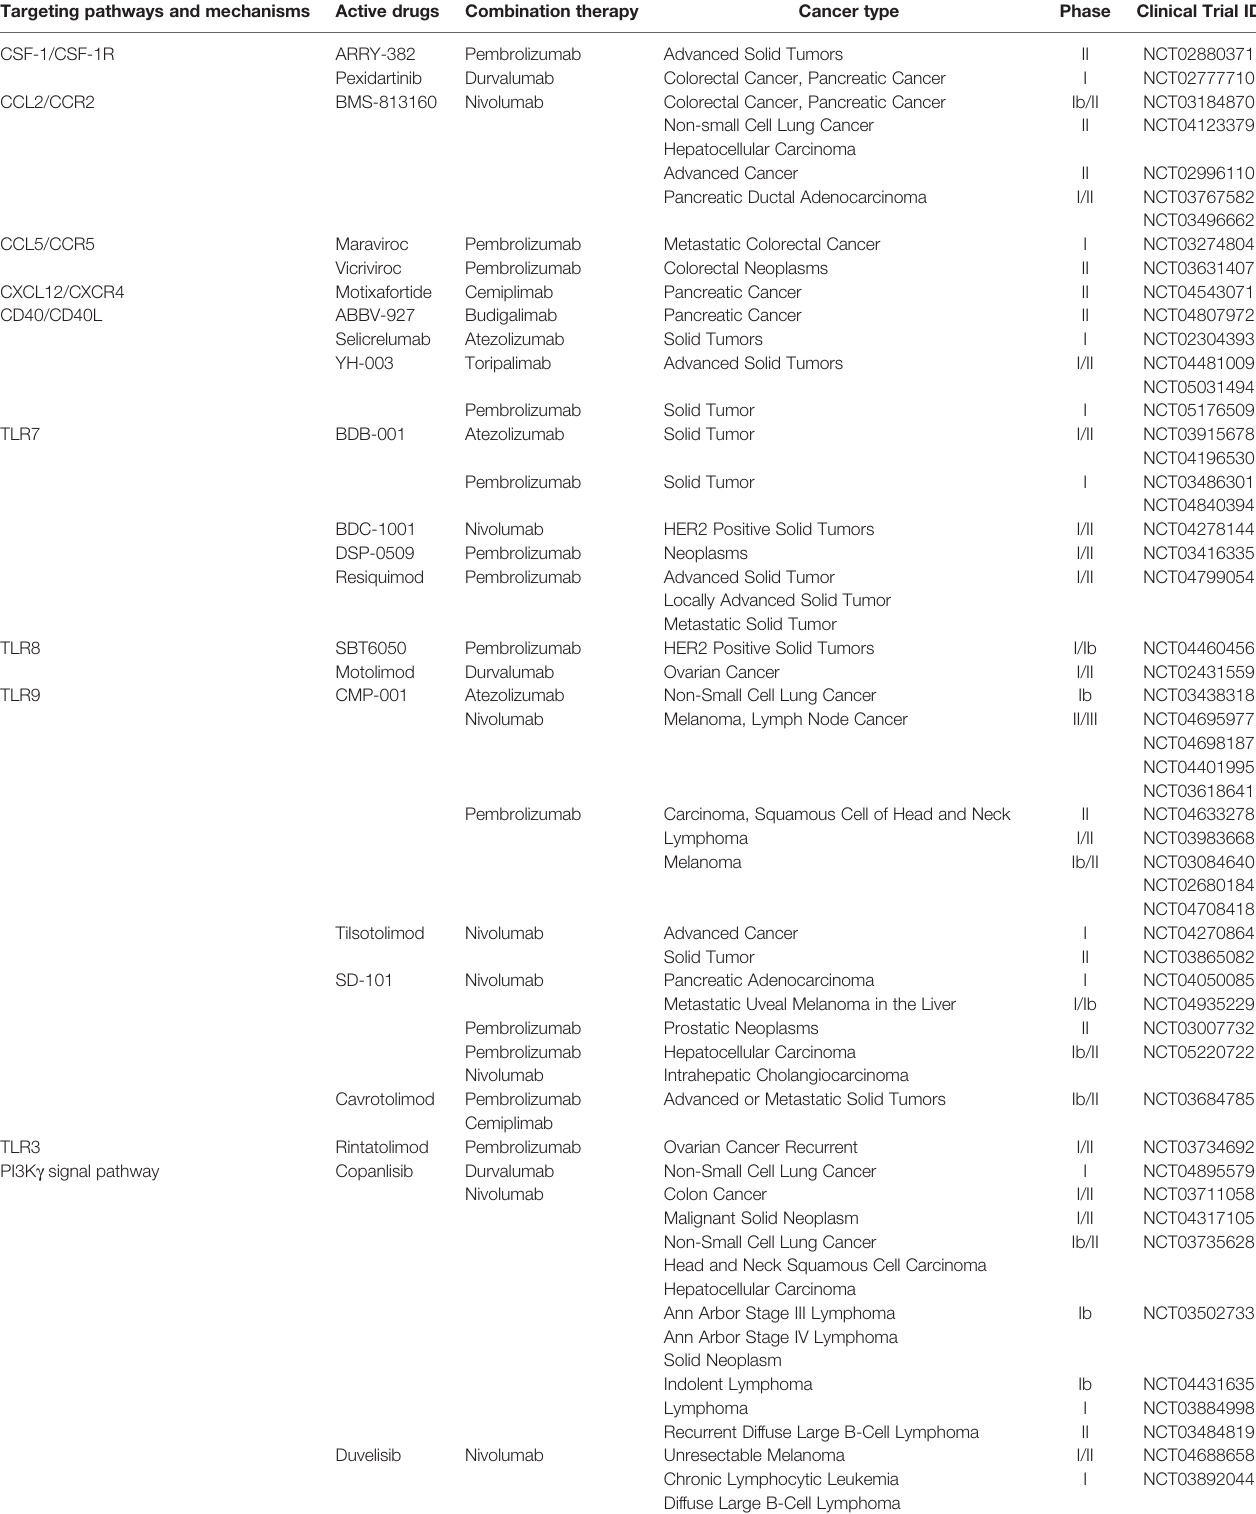
TABLE 1 | Characteristics of clinical trials and drugs on TAM-targeted therapy strati fi ed by targeting